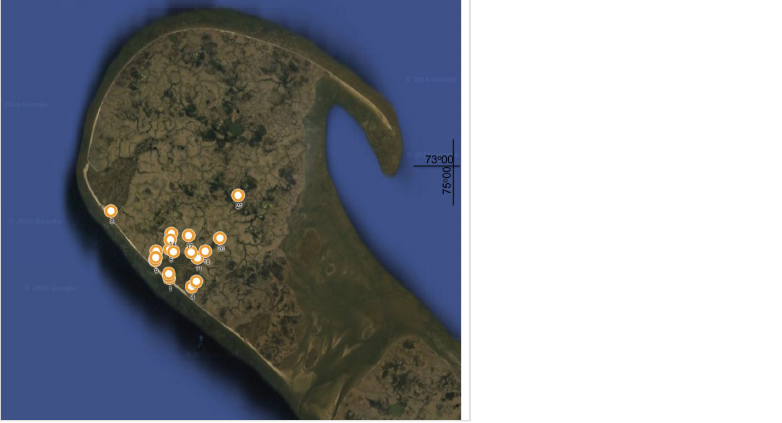
Figure 2. Location of the sampled stations in inner water bodies on the map of Shokalsky Island (Google Maps)